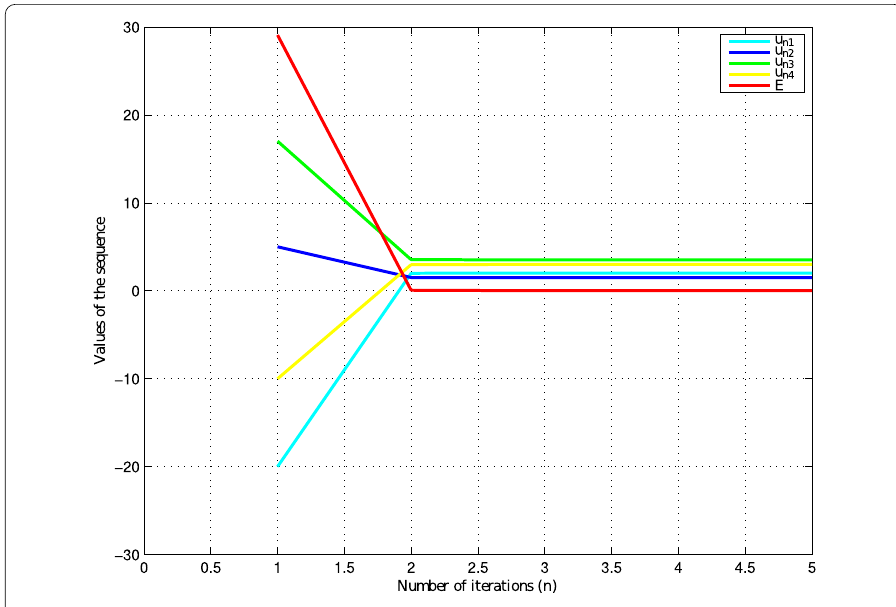
Figure 9 Convergence result of Theorem 3.11 with starting point of Case 5